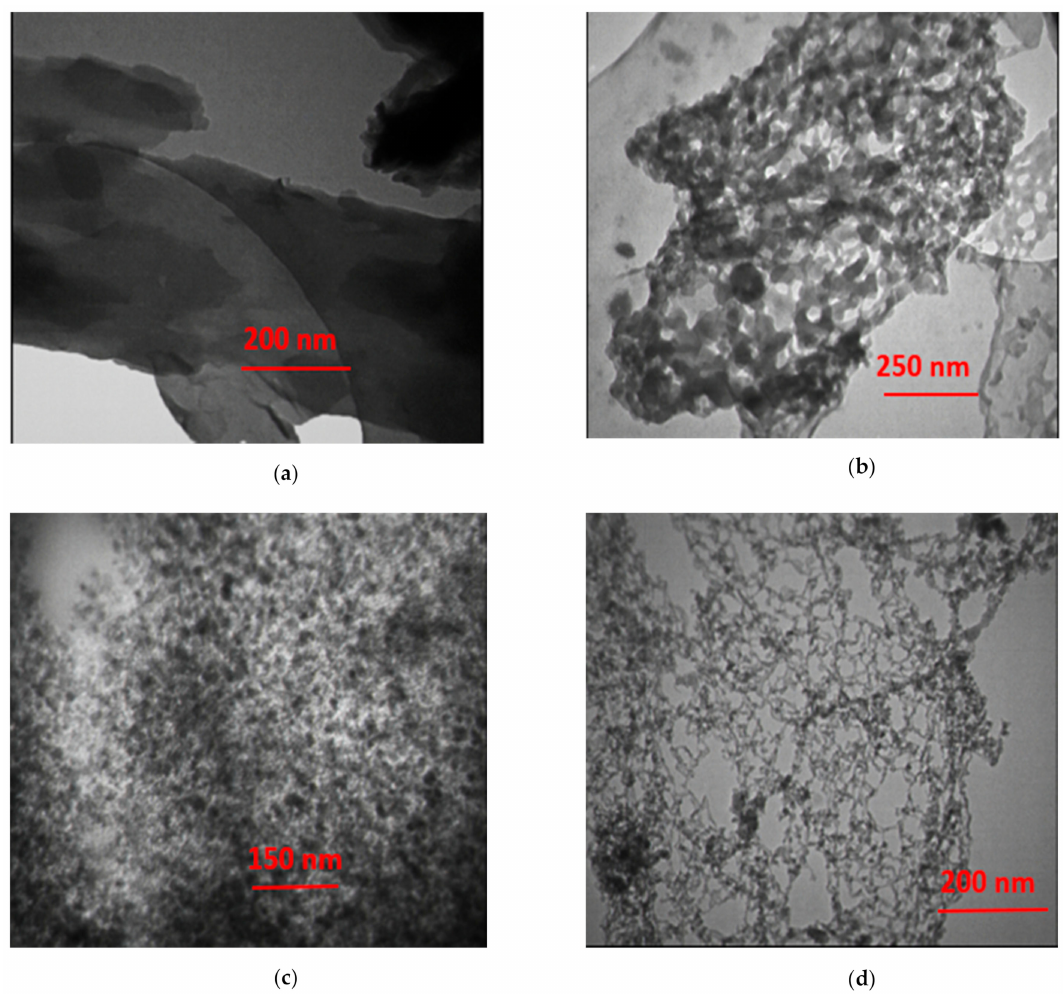
Figure 3. TEM images from different angles of m-GO ( a , b ) and PIL(low)@TiO 2 ( c , d ). TEM of PIL(low)@TiO 2 : The transmission electron microscopy (TEM) of PIL(low)@ TiO 2 (shown in Figure 3c) indicates the homogeneous distribution of nanoparticles. It can attribute to the well-dispersed process. Moreover, covering titanium dioxide nanoparticles with polymer chains is clearly shown in Figure 3c,d. SEM of m-GO : The SEM images clearly show the three-dimensional graphene oxide sheet, which possesses a structure similar to a sponge. The accumulation of layers in some areas can be attributed to operational groups (Figure 4) [55,56]. Due to each element’s unique atomic structure, the energy generated by electron transfer between two layers with different energies is shown in the graph of EDX (Figure S1). coated with polymer chains that surround titanium dioxide nanoparticles (Figure